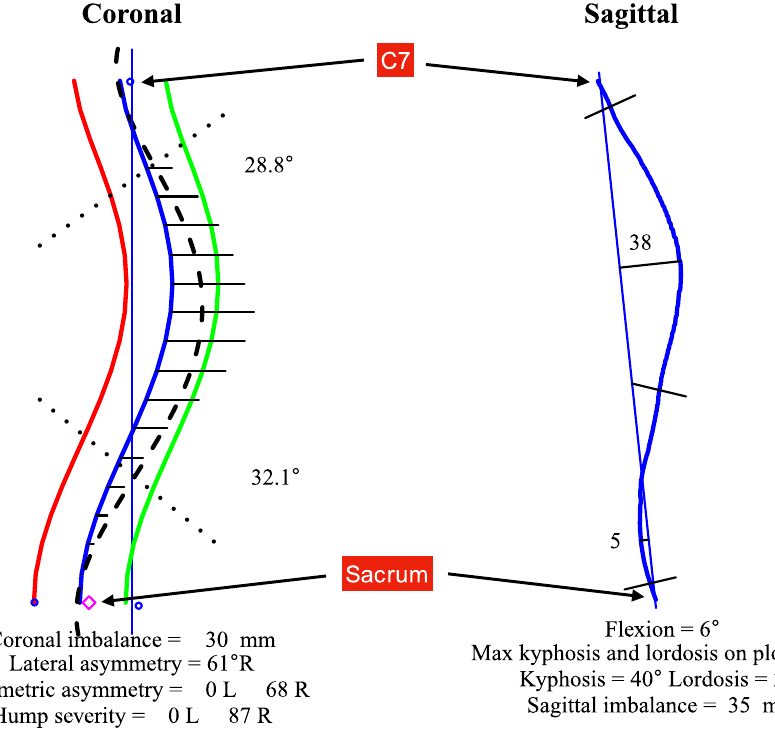
Figure 3. A close up of the key features of the ISIS2 analysis showing both the coronal and sagittal shape of the spine where the position of C7 and the sacrum are highlighted. The measures of coronal and sagittal imbalance are automatically recorded as shown.